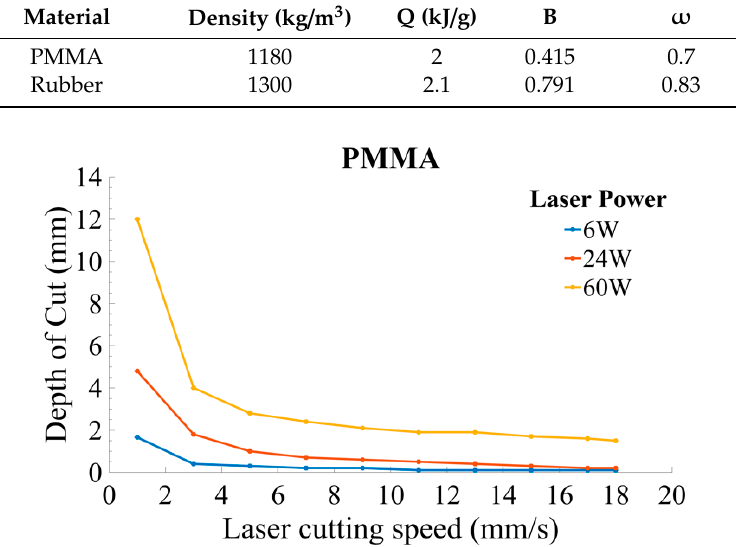
Table 4. Properties values for di ff erent polymers [45].